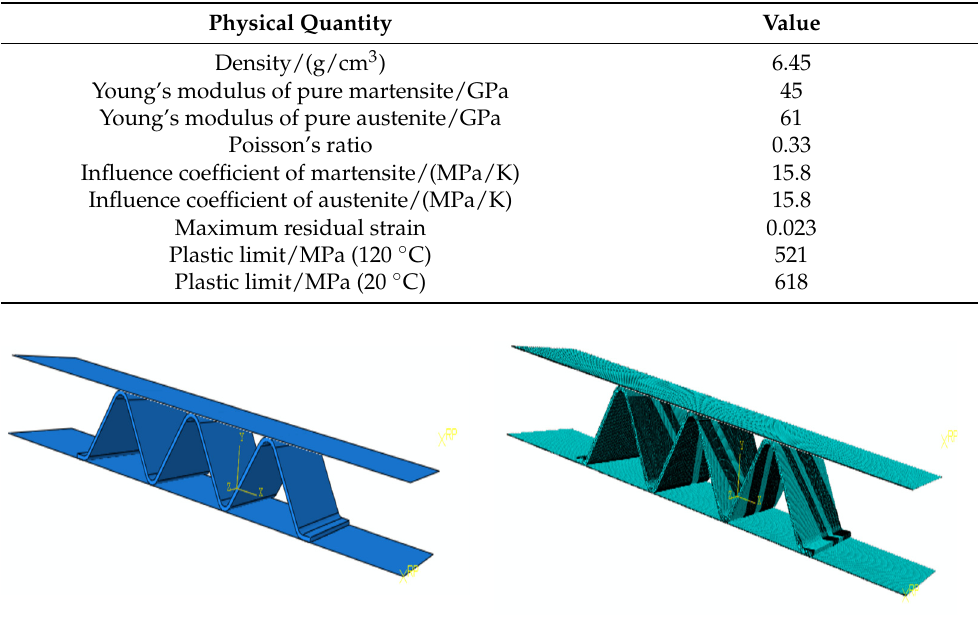
Table 2. Physical parameters of NiTi alloy.